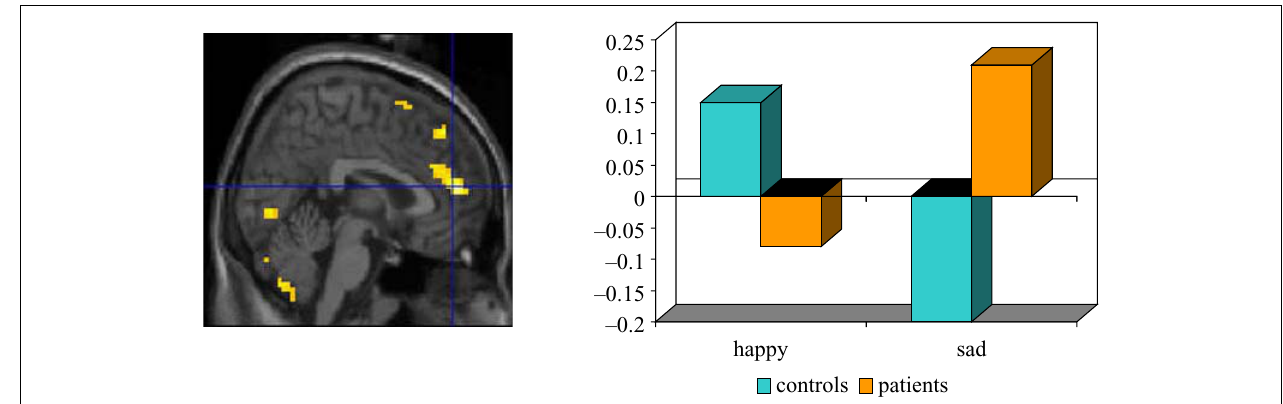
FIGURE 1 | Ventral ACC response to sad targets in depressed patients and happy targets in controls performing an affective go/nogo task. The left panel shows the focus of BOLD response and the right panel shows the adjusted BOLD response to happy and sad targets in patients and controls within this focus. Adapted from Elliott et al.